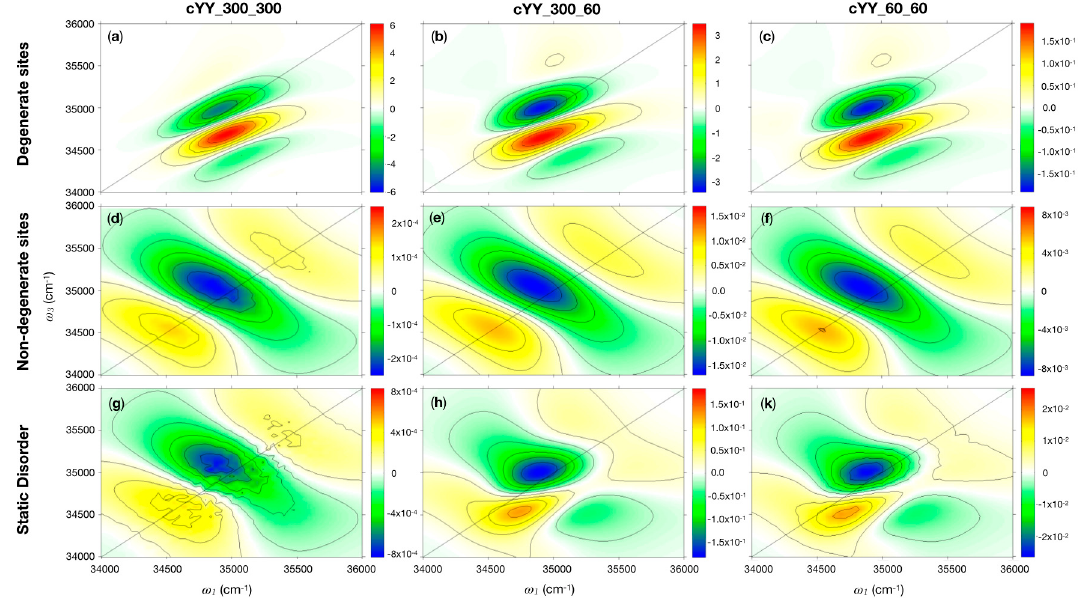
Figure 3. 2DUV spectra with xxxx − 3xxyy polarisation for cYY_300_300, cYY_300_60, and cYY_60_60 conformers are compared in the case of degenerate sites and, consecutively, strong wave function mixing ( a – c ), for non-degenerate sites (very weak/null wave function mixing) ( d – f ), and for static disordered (a variety of wave function mixing configurations in the ensemble) spectra ( g – k ). The intensity has been renormalised to the number of Tyr, and, in the case of static disorder spectra, also for the number of snapshots (500).